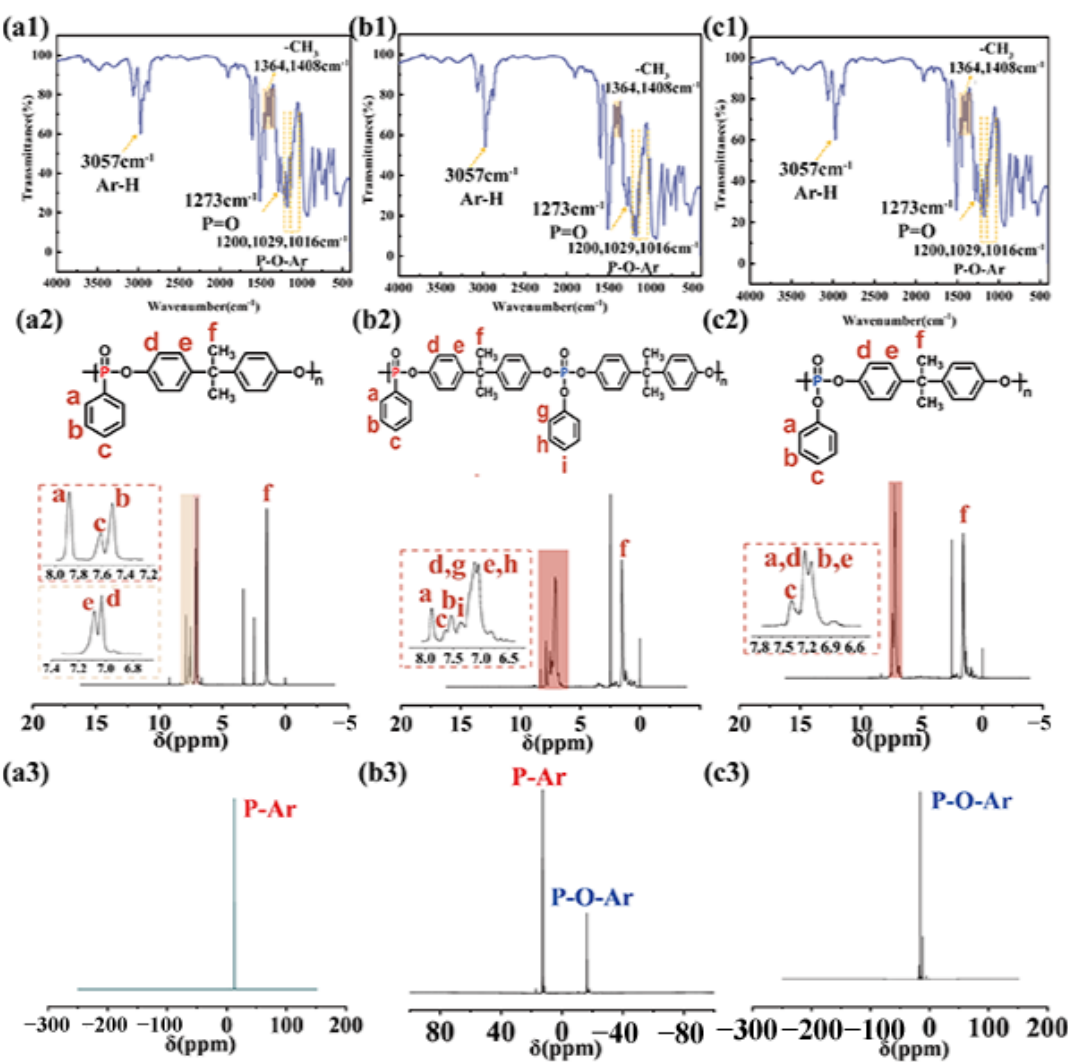
Figure 1. FTIR spectrum ( a1 , b1 , c1 ), 1H ( a2 , b2 , c2 ) and 31P NMR ( a3 , b3 , c3 ) spectra of PBPP, PBPDP and PBDP.